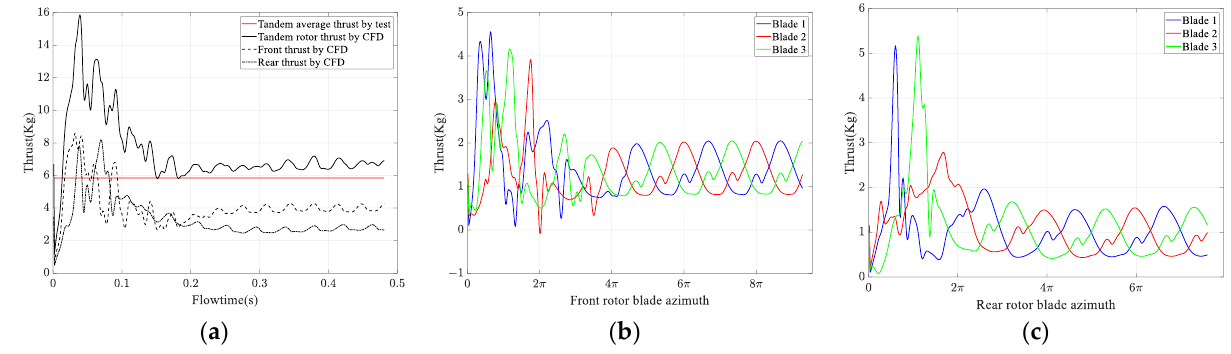
Figure 14. Numerical results of tandem rotor forward autorotation at V x = 15 m/s, θ = 10 deg , θ 0 = − 2 deg. ( a ) Convergence process of the rotor thrust compared with test results; ( b ) front rotor blade thrust; ( c ) rear rotor blade thrust.